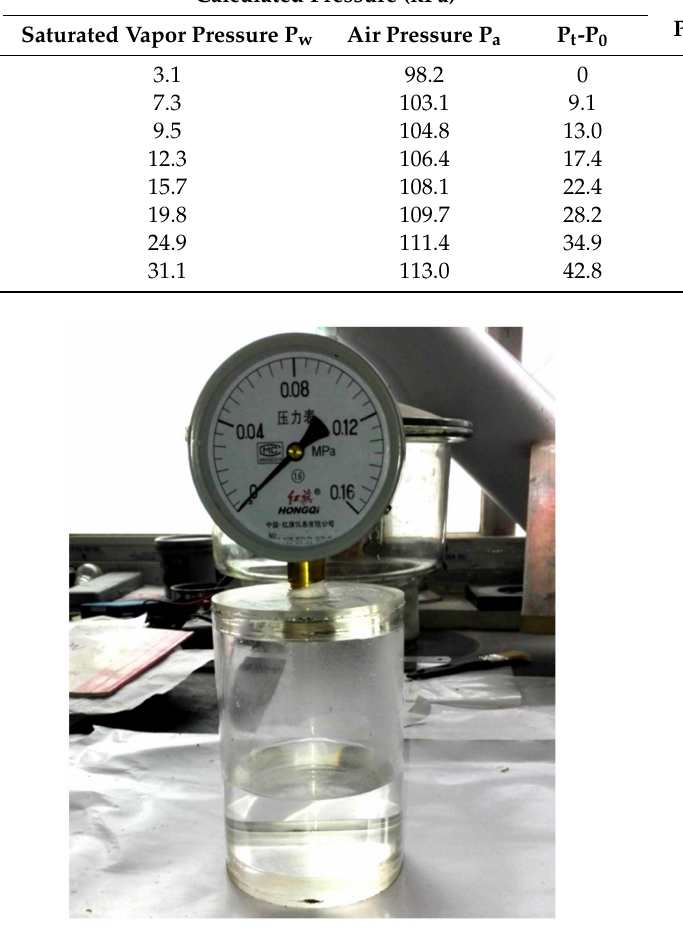
Table 3. The pressure value in the vessel (calculated and tested, initial temperature T 0 = 25 ◦ C). Temperature ( ◦ C)